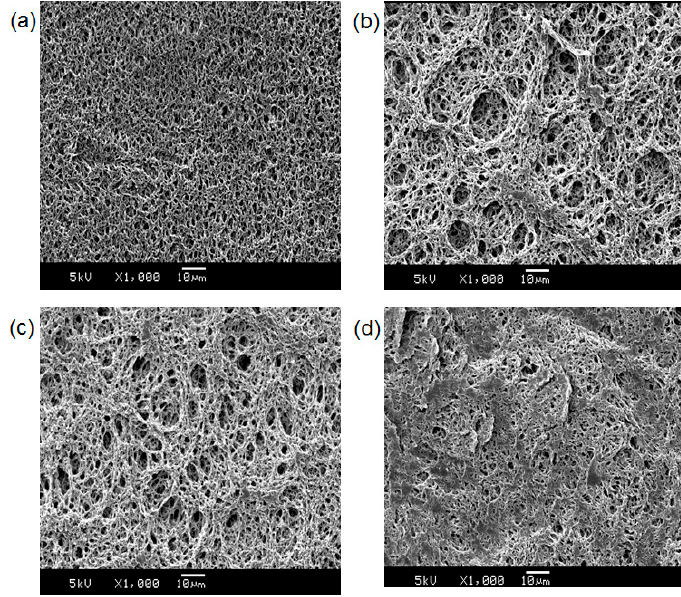
Figure 6. SEM images of the ( a ) original PVDF; ( b ) buffer-treated antibody-PDA coated PVDF; ( c ) BSA-treated antibody-PDA coated PVDF; and ( d ) virus antigen-treated antibody-PDA coated PVDF.